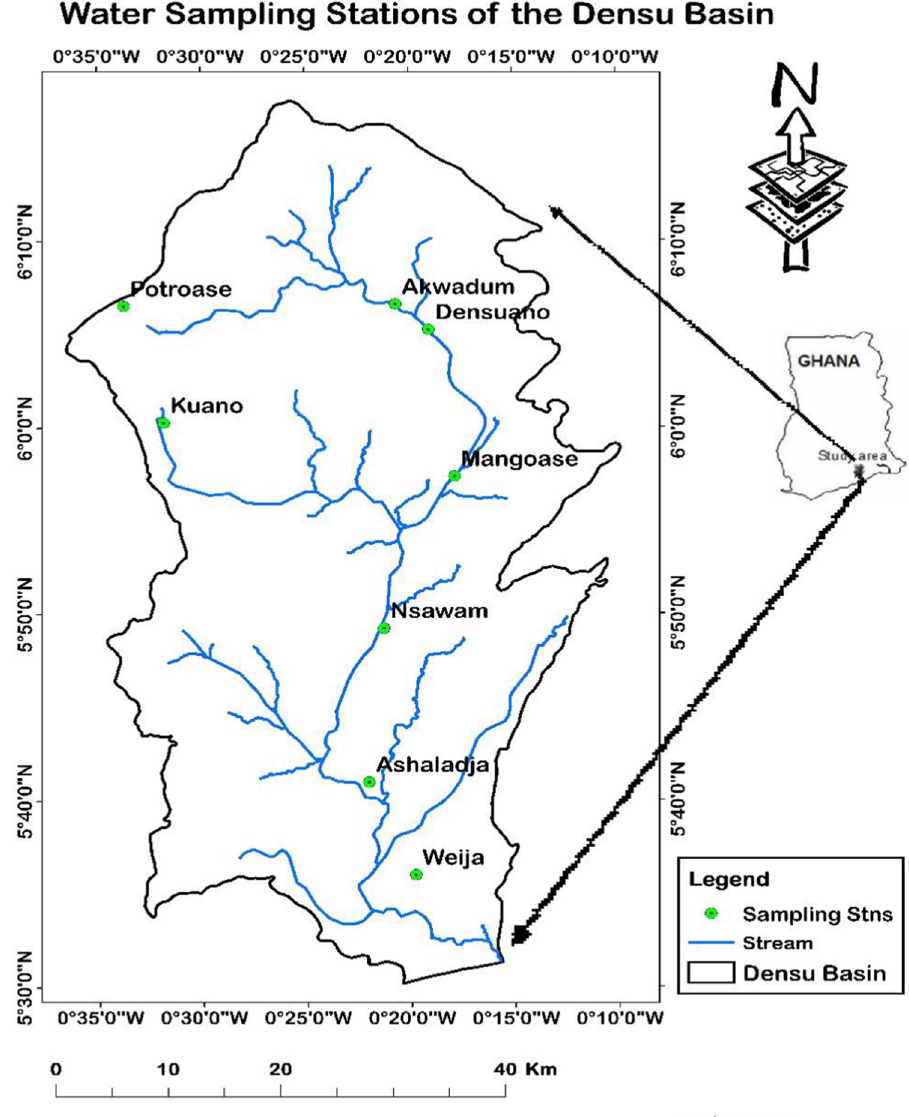
Fig. 1 Densu river basin with water quality sampling